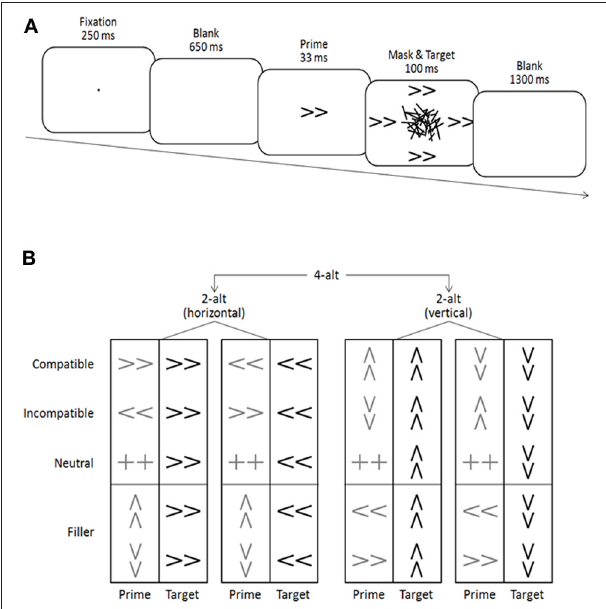
FIGURE 1 | (A) Schematic illustration of a (compatible) trial. (B) List of all possible trials in the two 2-alternative (2-alt) choice tasks and the combined 4-alternative (4-alt) choice